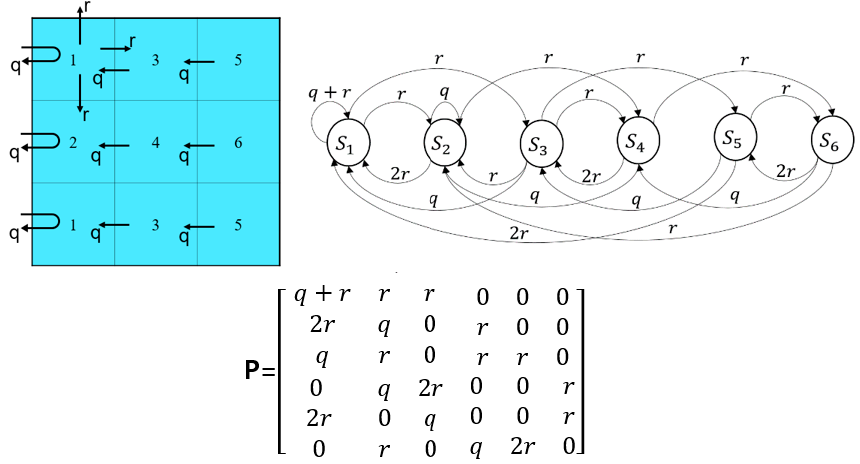
Figure 8. State transition diagram and state transition probability matrix ( n = 9).